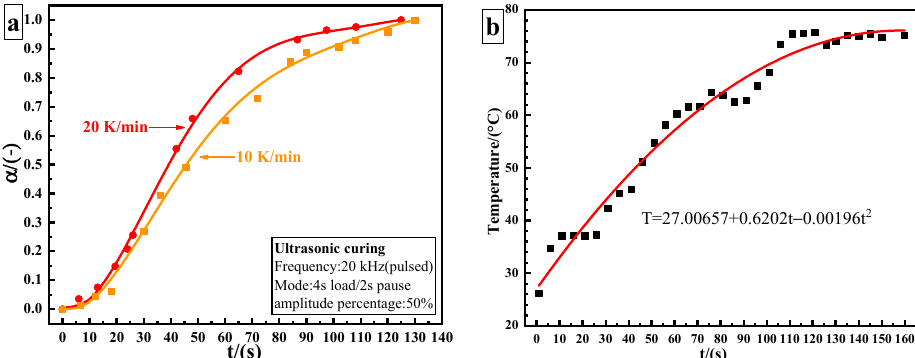
Figure 3. Ultrasonic curing results of 3M DP420 epoxy adhesive: ( a ) curing degree as a function of time; ( b ) internal temperature curve of the adhesive by utilizing ultrasonic curing.